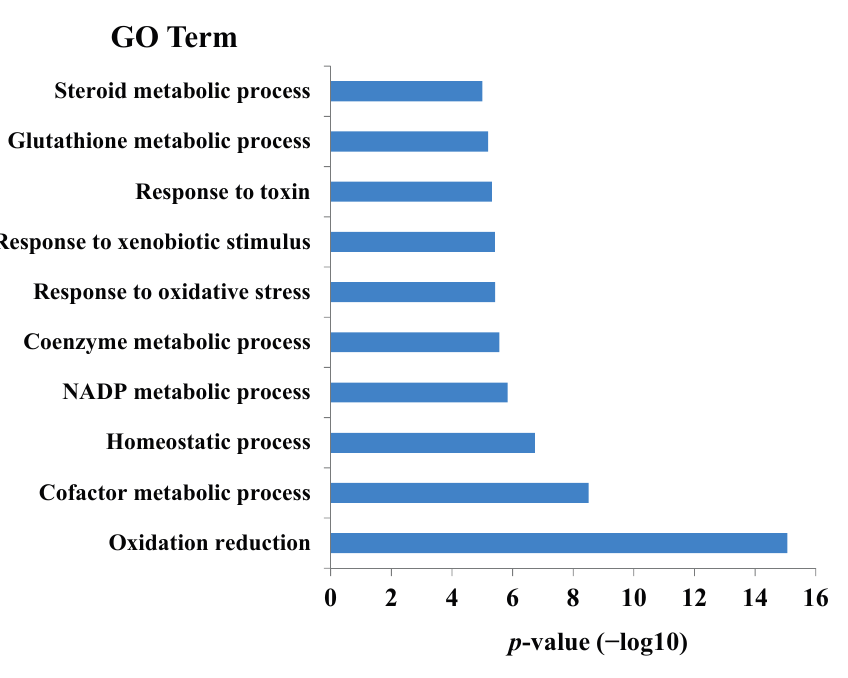
Figure 1. The enriched GO function of module 27 of cMap-Si-Wu-Tang dataset, with p -values adjusted by False Discovery Rate calculation using Benjamini-Hochberg method [24].